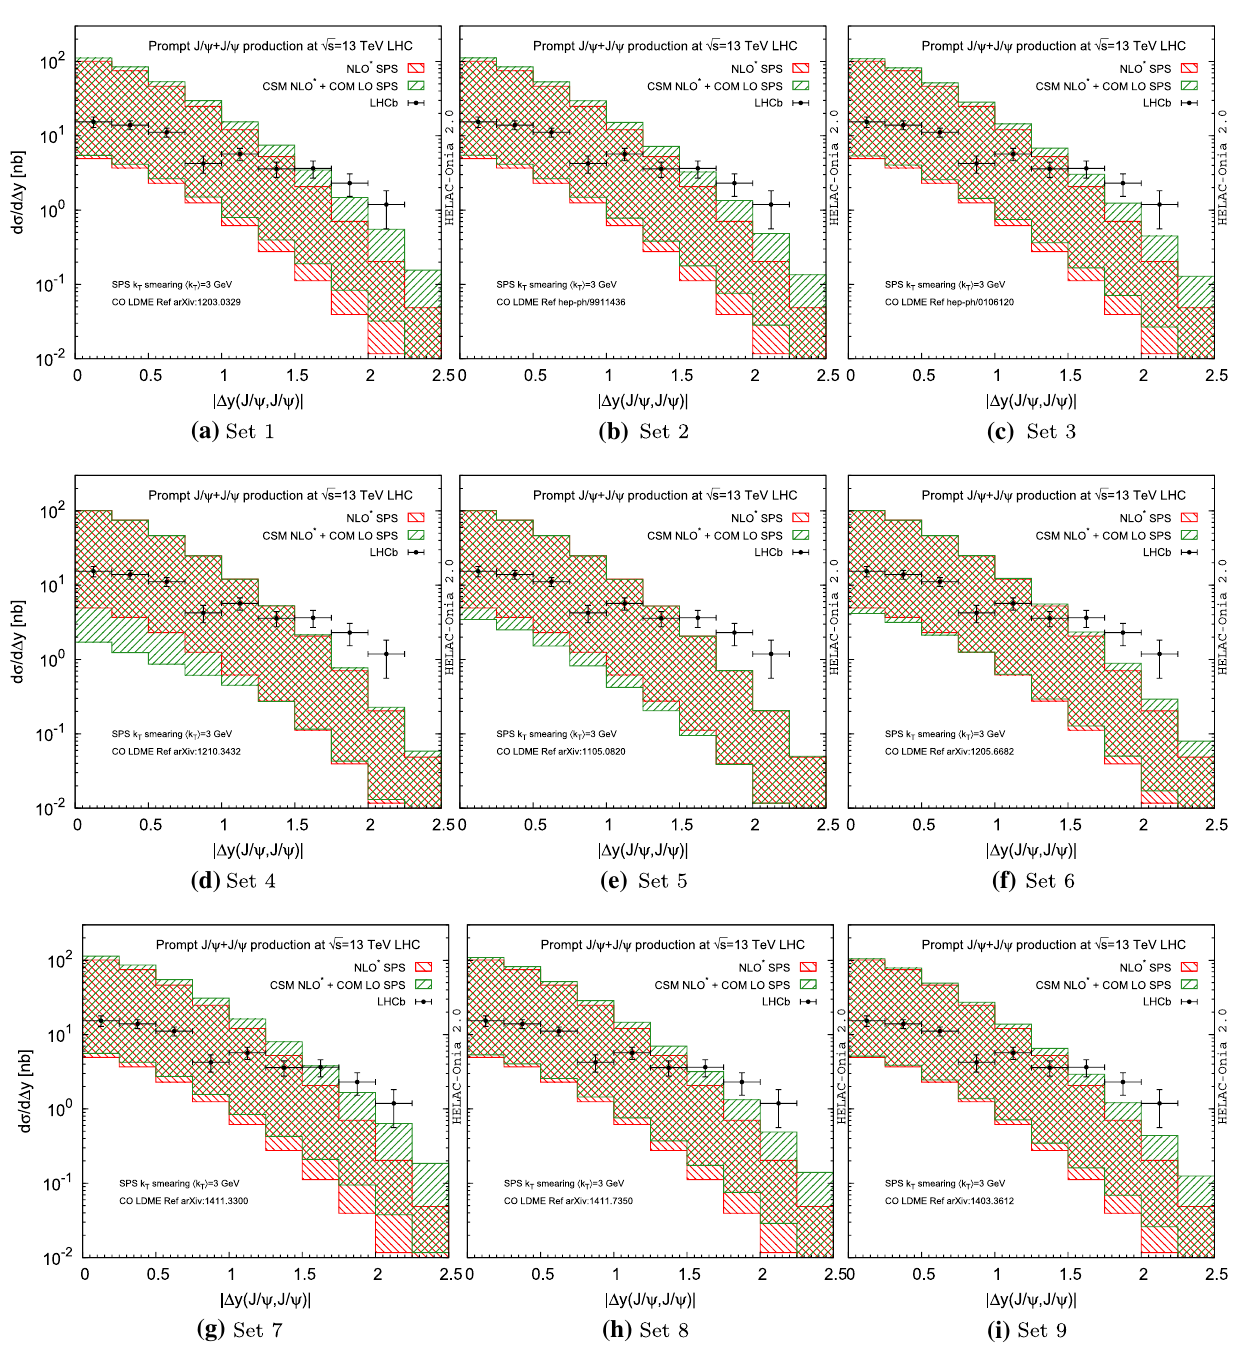
Fig. 4 Δ y ( J /ψ, J /ψ) distributions in NLO (cid:11) CS and LO CO via SPS within LHCb